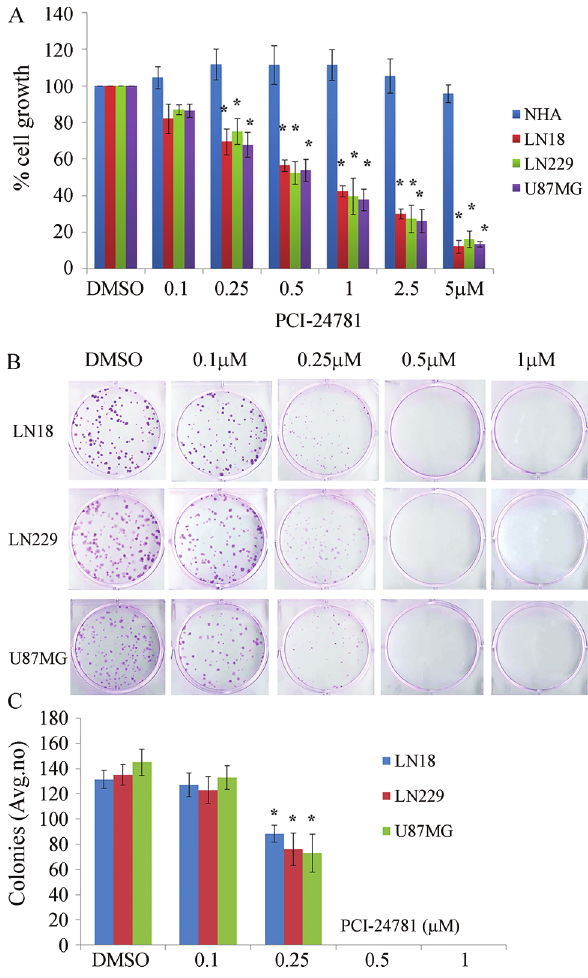
Figure 1 - PCI-24781 inhibits the growth of malignant glioma cells. (A) MTS analysis of normal astrocytes and three malignant glioma cell lines. (B)Formationofmalignantgliomacellcolonies.(C)Numberofsurviving colonies. In panels (A) and (C) the columns are the mean (cid:5) SD of 3 deter- minations. *p < 0.05 compared with the DMSO